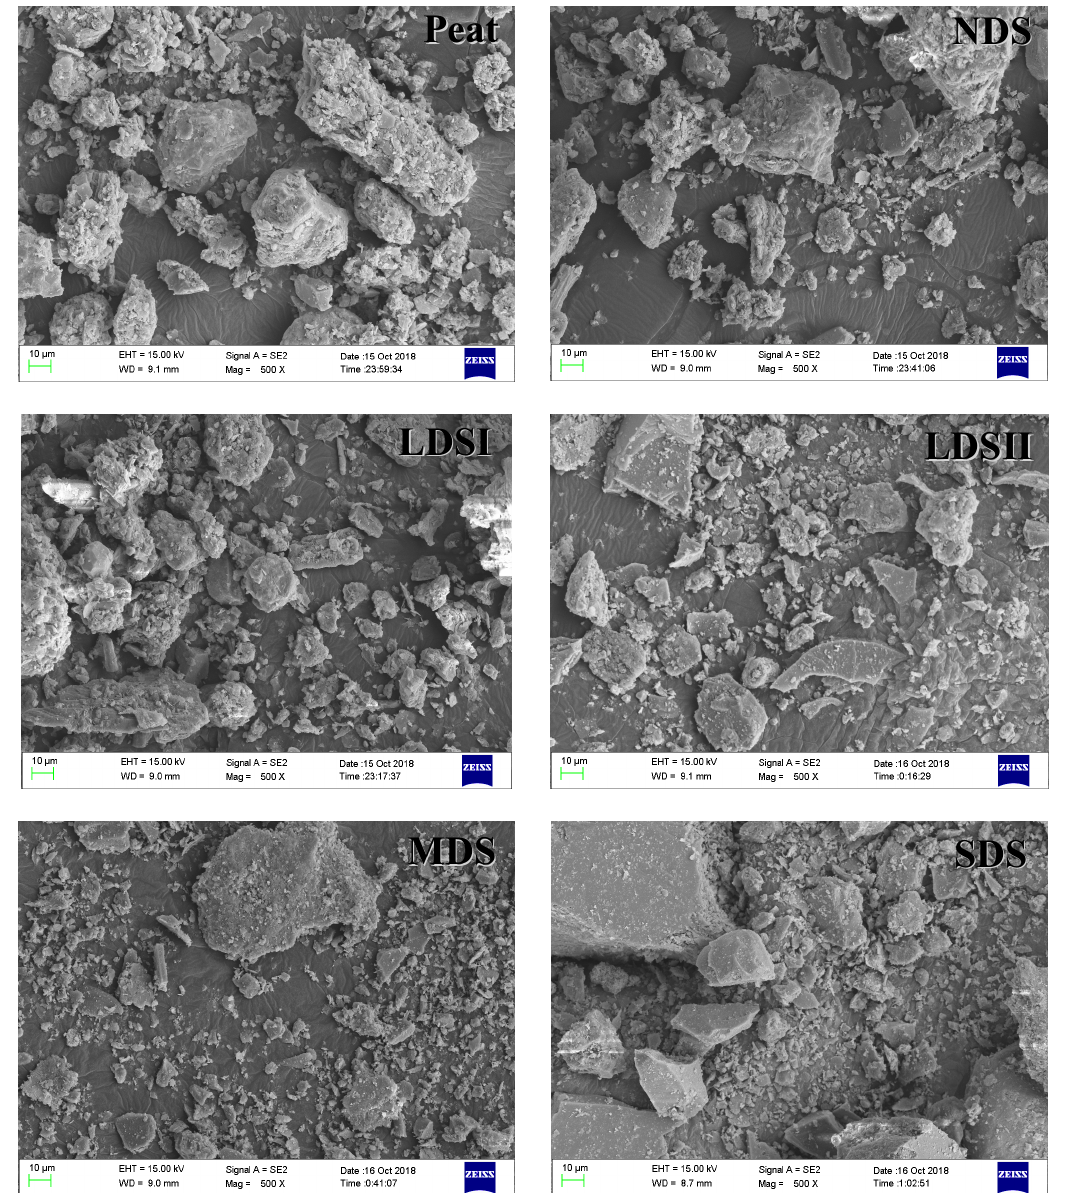
Figure 2. The SEM images of the six selected soils.